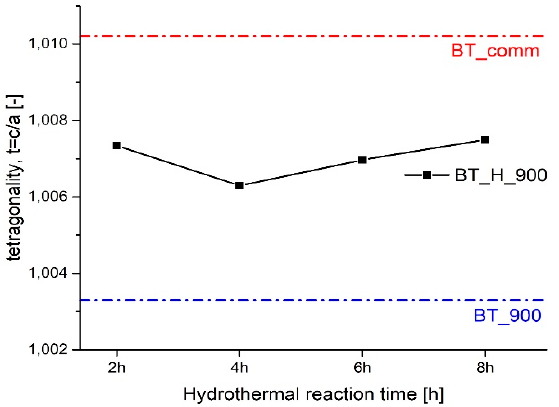
Figure 8. Trend of tetragonality as a function of the hydrothermal reaction time.